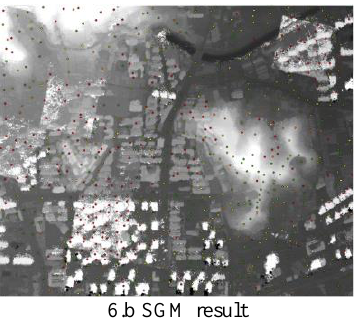
Figure 6. Elevation residual distributions of different levels Figure 7. Comparison of the residuals of the two methods From the results of the regional distribution of residuals, it can be seen that the two methods in the shadowed area of the image will produce false matching points. On the other hand, from the comparison of the number of residuals at different levels, the reliability of SGM matching is slightly higher than that of LSM method.